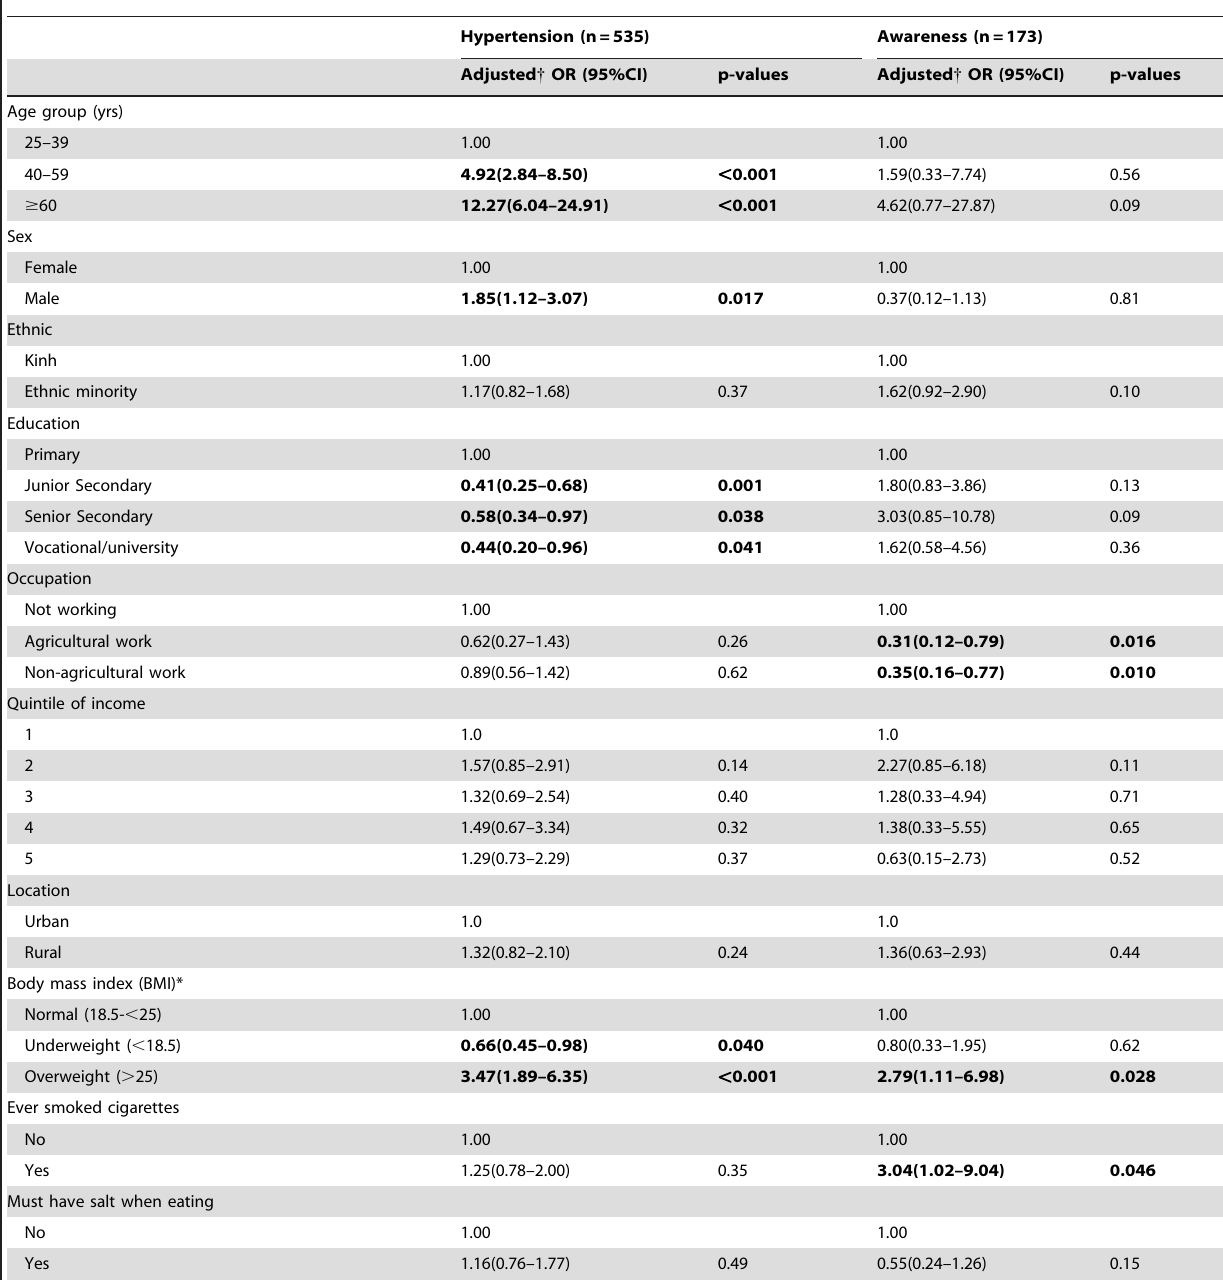
Table 3. Factors Associated with Prevalence and Awareness of